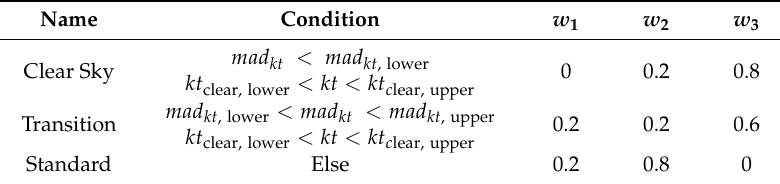
Table 7. Weighing factors for the combination of df 1 , df 2 and df 3 to one single df , depending on kt characteristics.